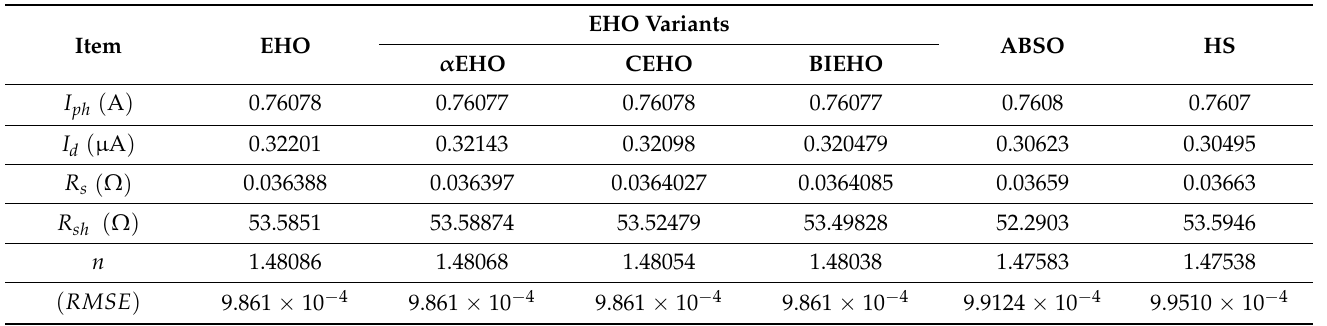
Table 3. Comparison between EHO algorithms, ABS, and HS for single-diode solar